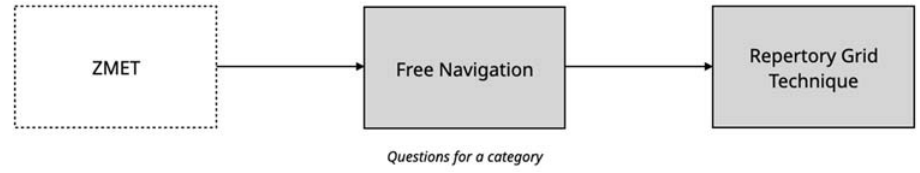
Figure 3. Study 2 Procedure.